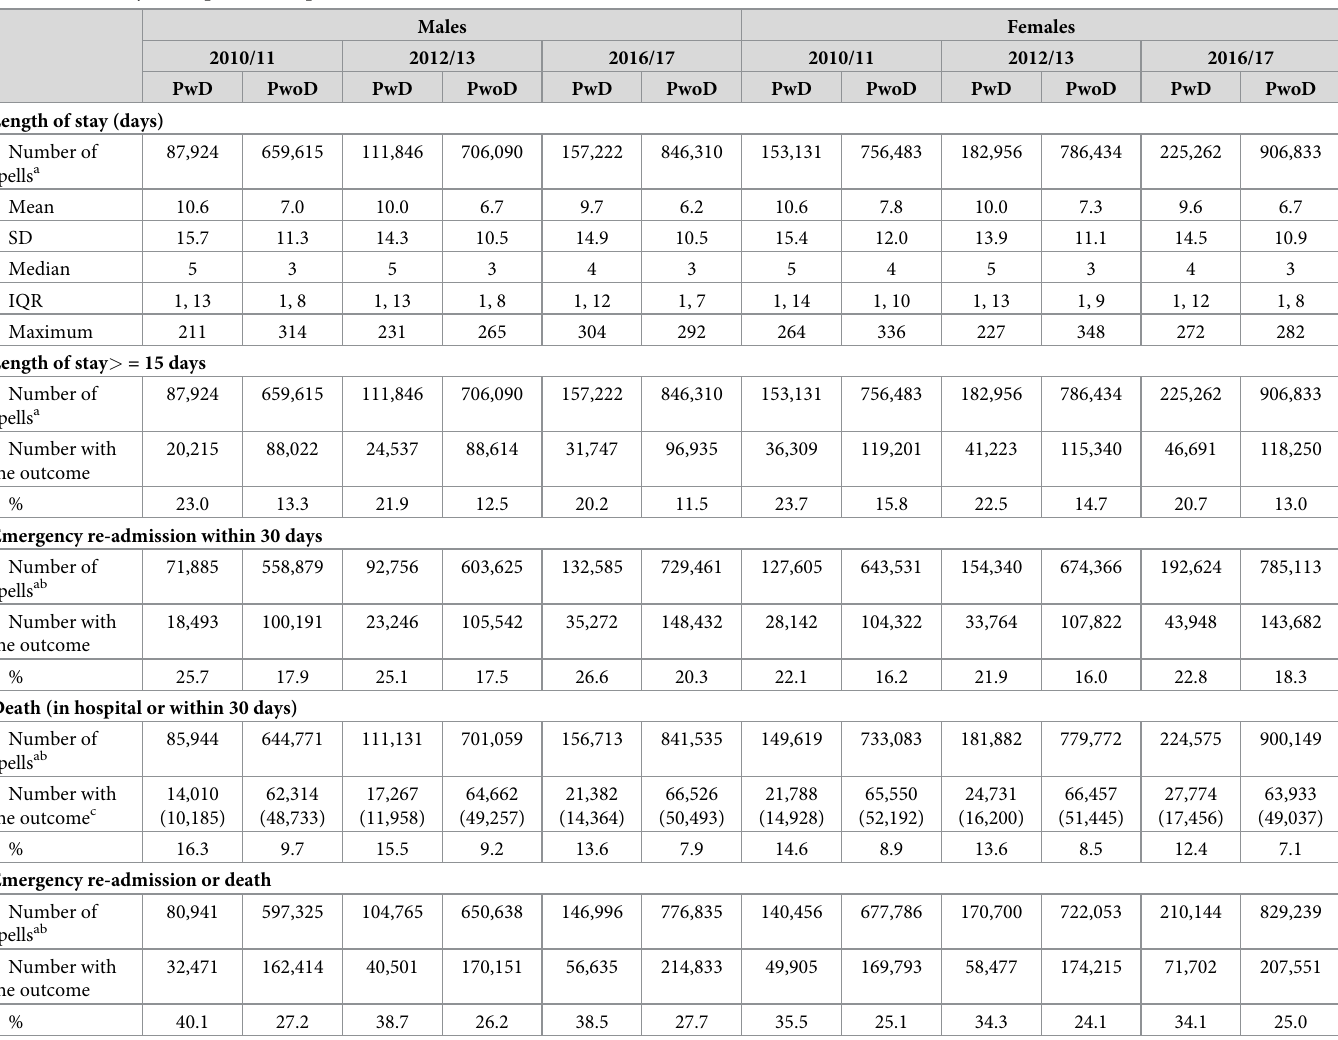
Table 3. Summary of samples and hospital